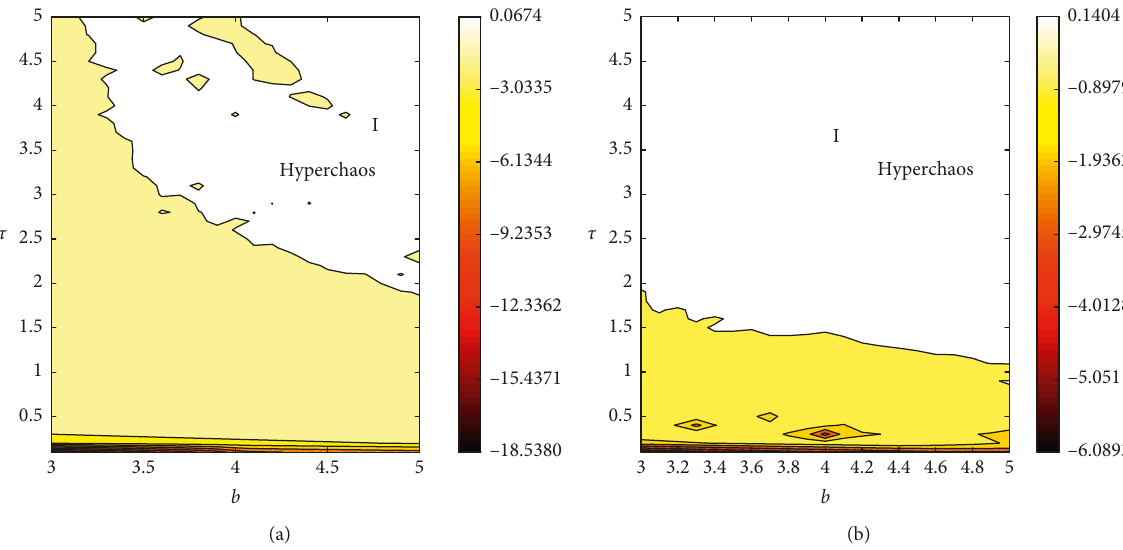
Figure 13: (a) The 2D LE diagram showing the second largest Lyapunov exponent ( λ 2D LE diagram showing the second largest Lyapunov exponent of the ACCM-Ikeda TD system in the ( b − τ )